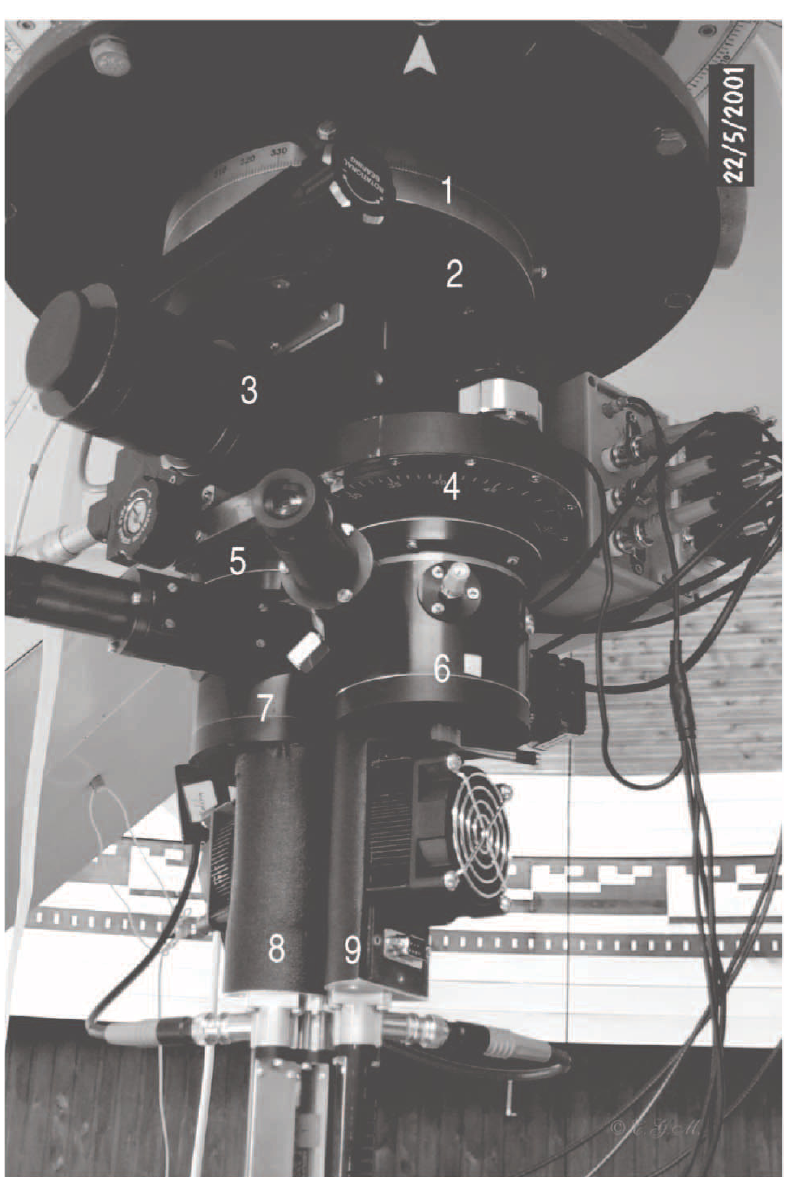
Fig. 2. The three-channel photometer: 1 – rotational bearing, 2 – cen- tering unit, 3 – movable field eyepiece unit, 4 – second channel movement unit, 5 – third channel movement unit, 6 – one-beam mini-photometer (miniphot), 7 – two-beam mini-photometer (miniphot), 8 – two-channel photoelectric head, 9 – one-channel photoelectric